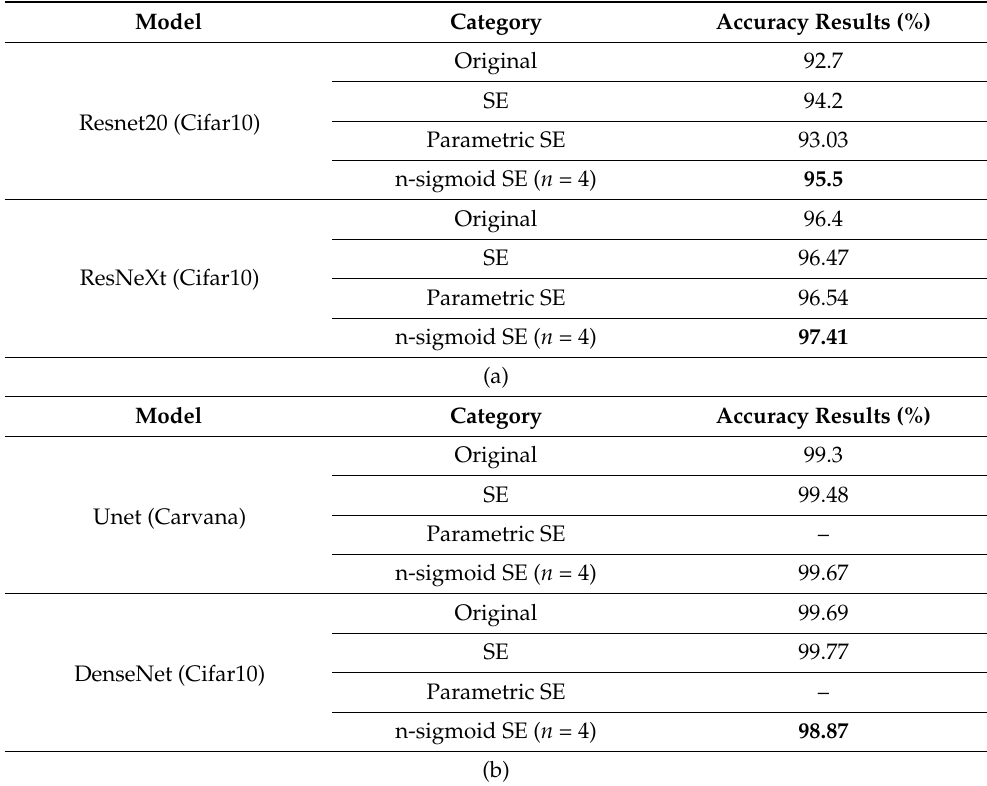
Table 3. Performance comparison of the state-of-the-art models for training accuracy on classification (a) and segmentation (b).